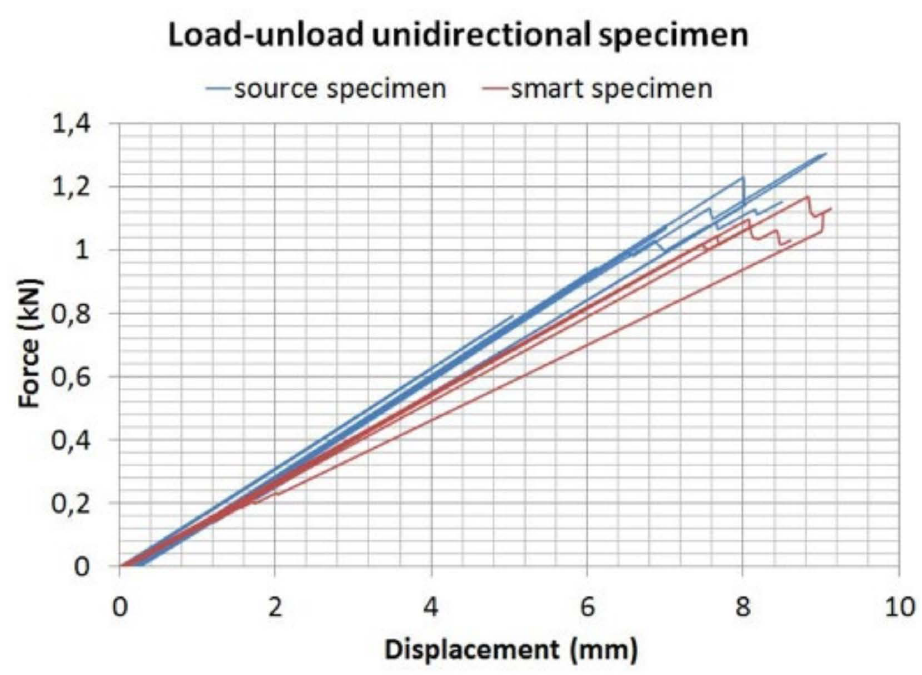
Figure 10. Force–displacement curve of unidirectional specimens under load–unload condition.